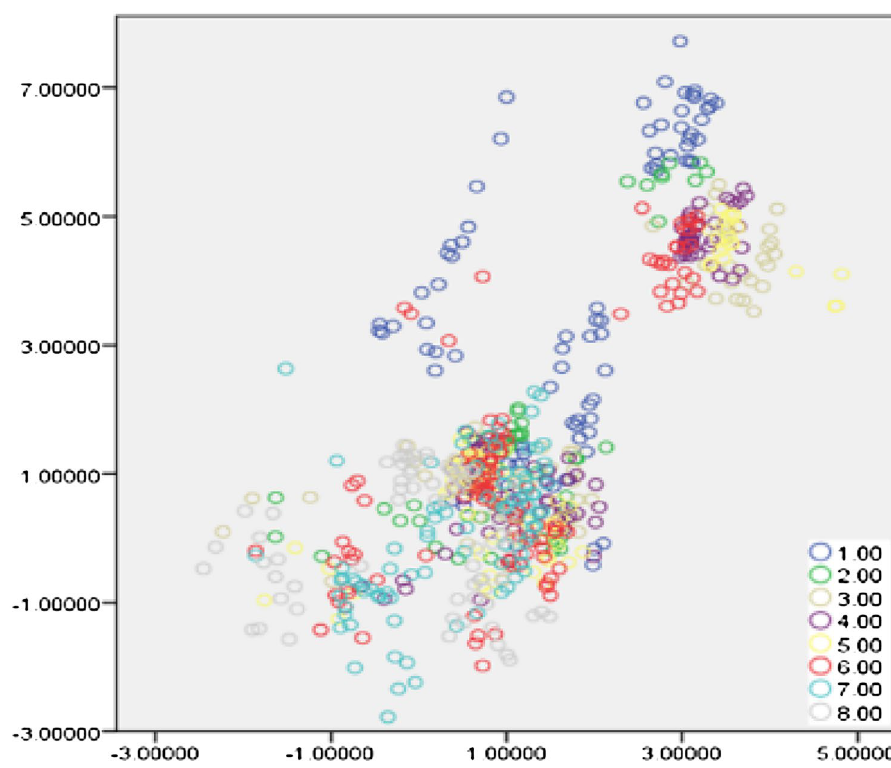
Fig. 3 The scatter plot with calculated component 1 and component